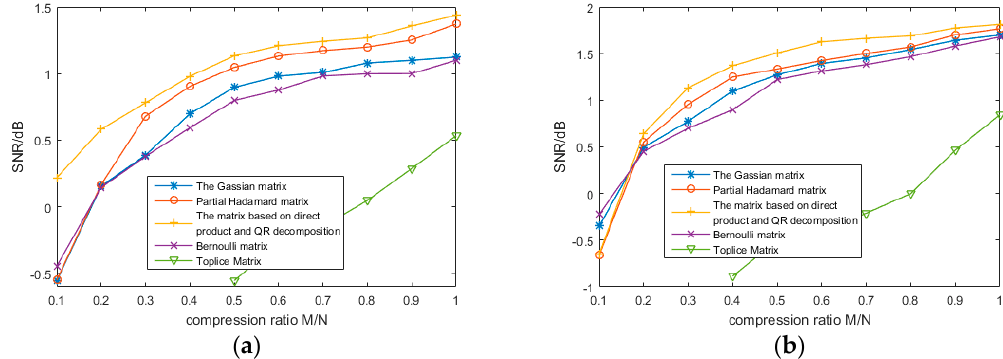
Figure 9. Change in SNR with the compression ratio. ( a ) echo with incident angle of 30°; ( b ) echo with incident angle of 45°.